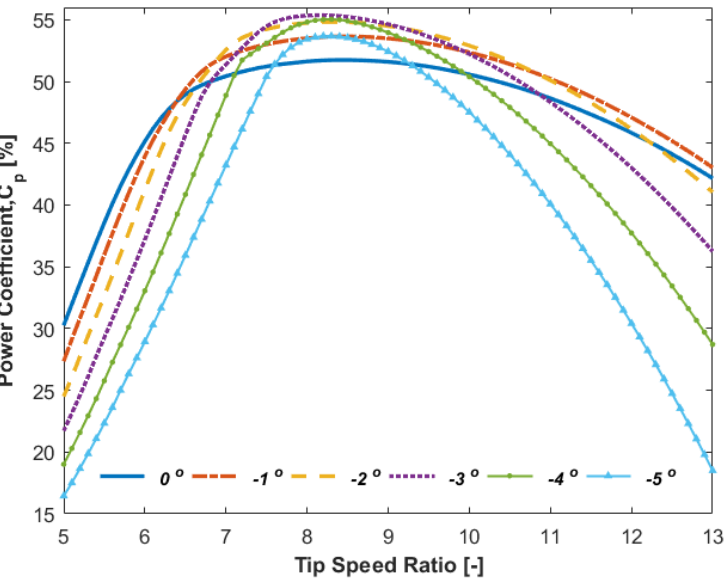
Figure 14. Power coefficient against tip speed ratio for different pitch angles at design conditions.